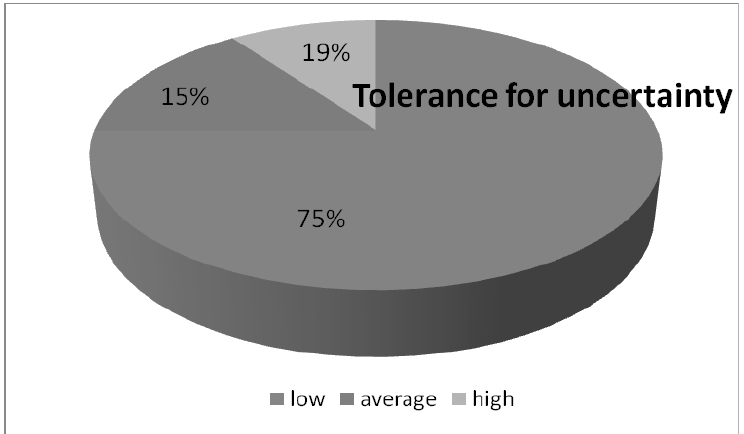
Fig. 2.1. Distribution of the University of the Third Age students on scale “Tolerance for uncerta- inty” according to PCRS method adapted by N. Bazhanov and G. Bardiyer. Source: Authors`